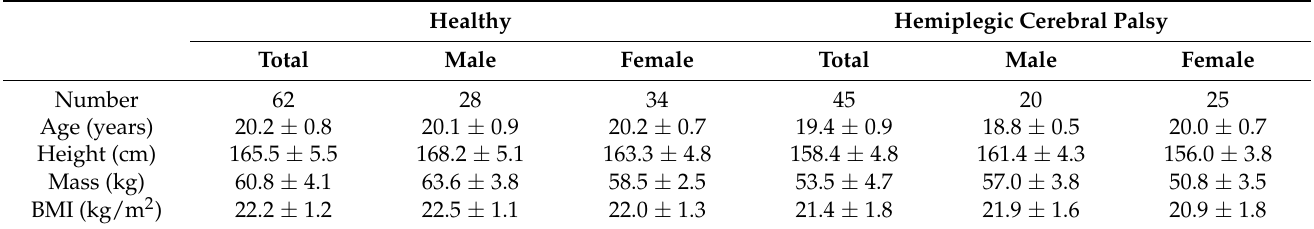
Abbreviations: BMI, body mass index. Data are presented as mean ± standard deviation